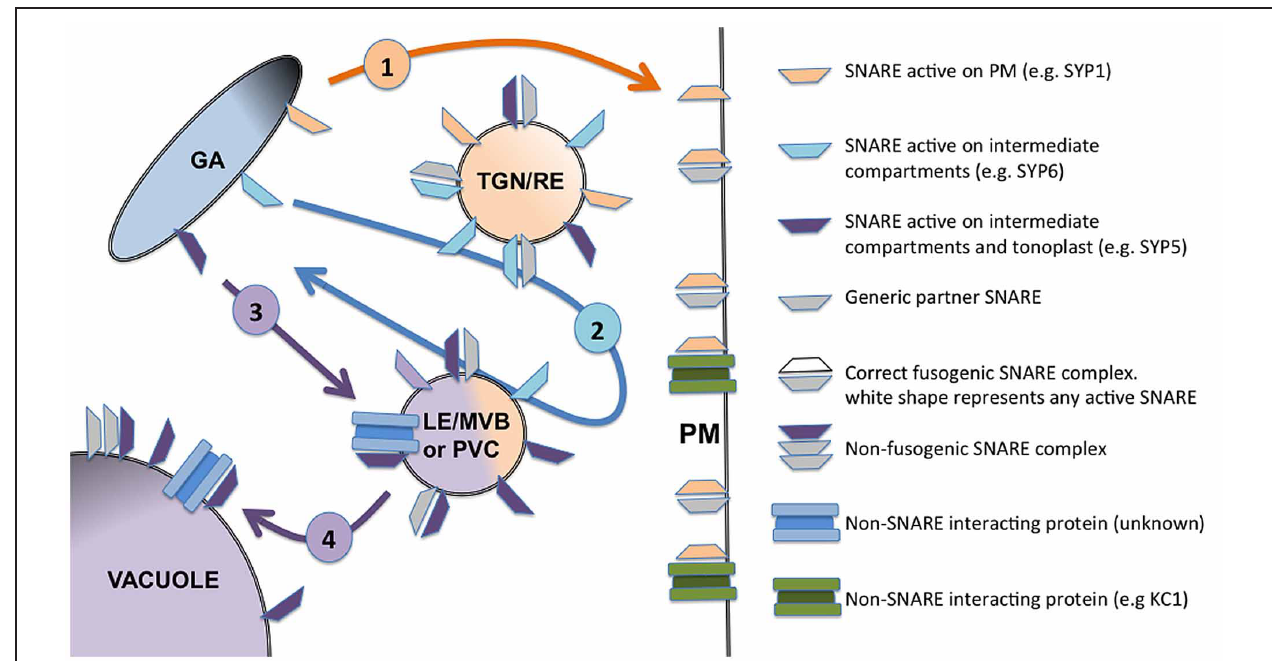
FIGURE 1 | Schematic representation of four distinct situations described for SNARE functioning in the post-Golgi membrane traffic. SNAREs active on the PM, such as for example SYP121 and other members of the SYP1 family, are sorted to the target membrane with an inactive conformation where they act as t-SNAREs. They can interact and eventually regulate non-SNARE partners (as shown for SYP121 and KC1 channel) but do not show interfering activity (1). SNAREs can also be specifically localized and active as t-SNARE on intermediate compartments, such as for example SYP61, localized on the TGN membranes (2). Some SNAREs can be distributed on